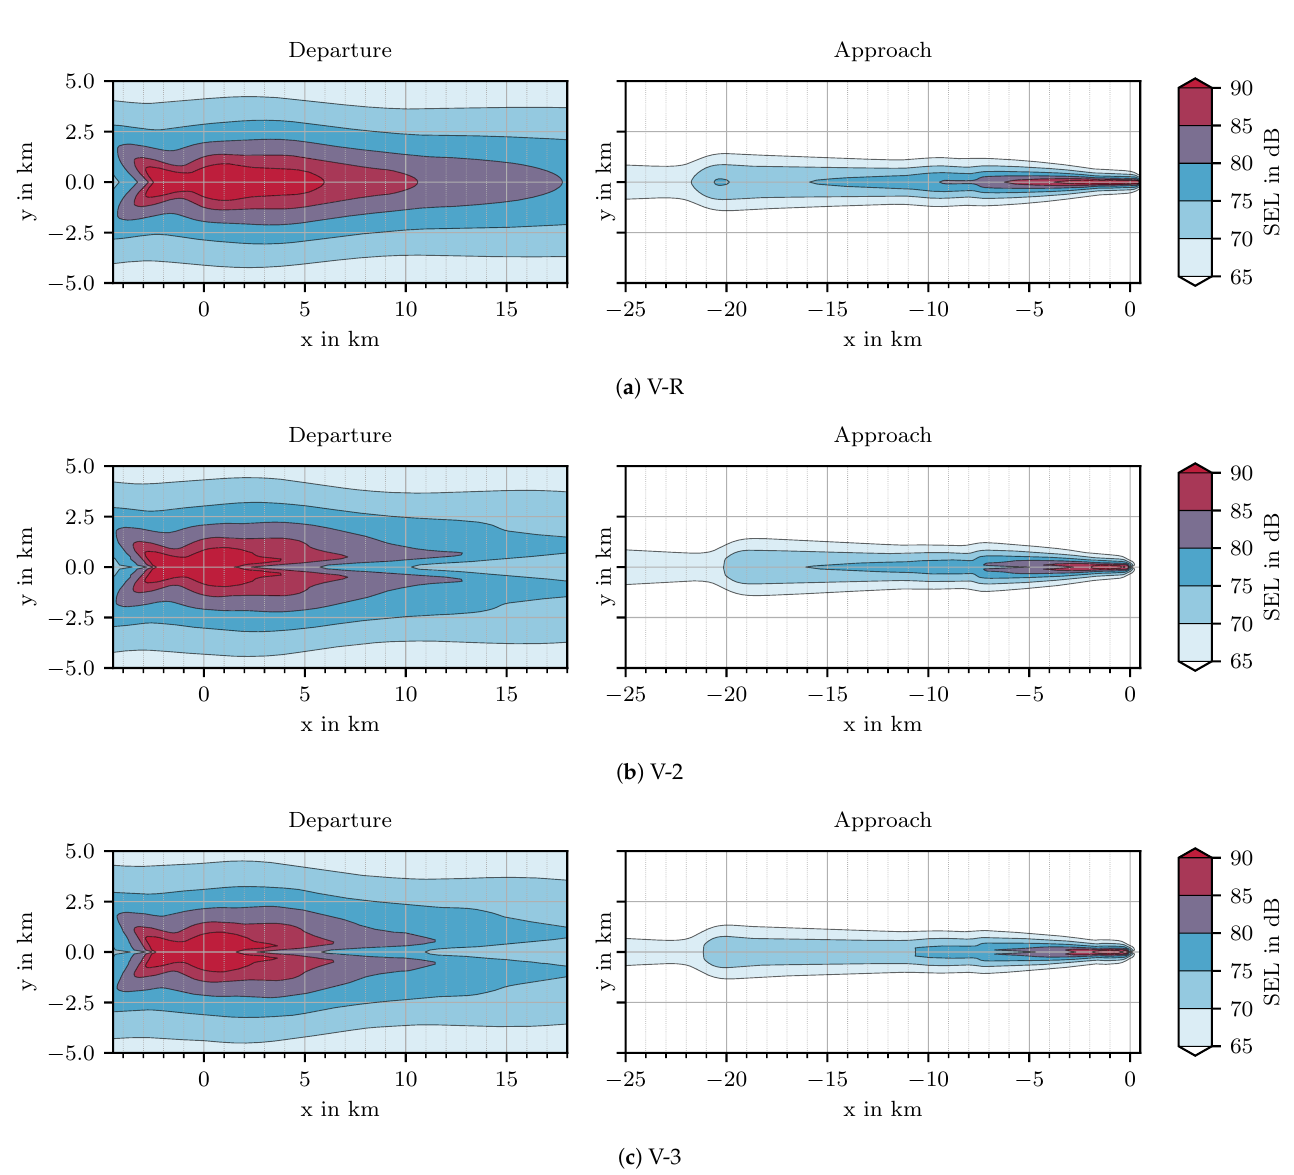
Figure A1. SEL contour of the ceo